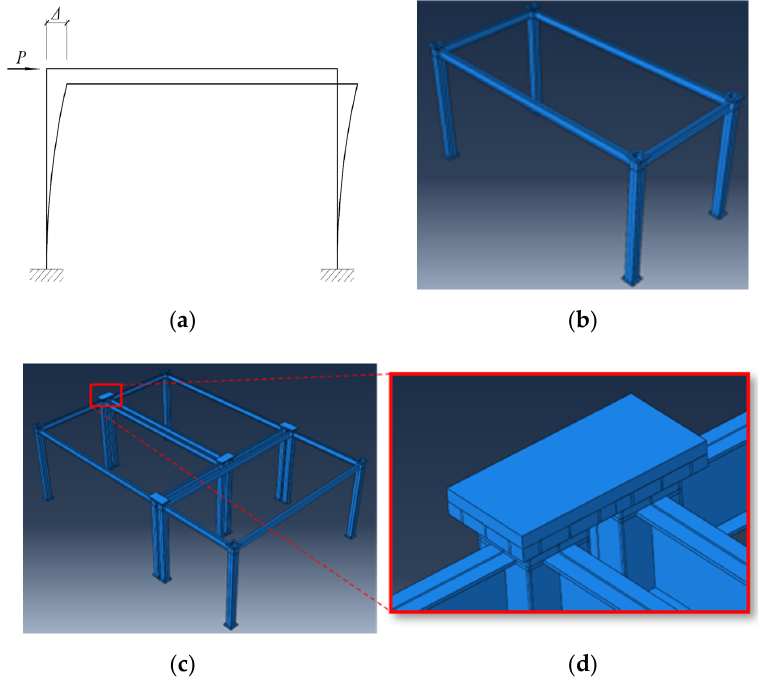
Figure 4. Finite element analysis: ( a ) calculation diagram and model of ( b ) scheme 1, ( c ) scheme 3 and ( d ) connecting plate.